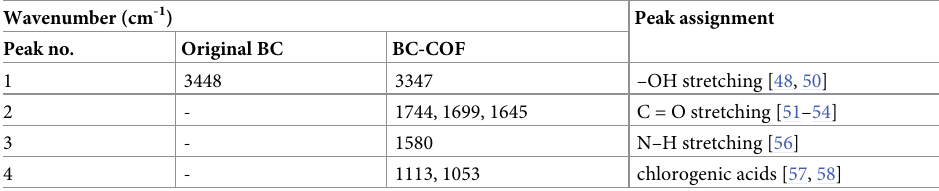
Table 1. Characteristics of peaks of original BC and BC-COF bio-leather (Extraction conditions: Liquor ratio of 1:10 (w/v), coffee at an amount of 200 wt% BC, 90˚C, 1 h; dyeing conditions: Fabric-to-liquor ratio of 1:10 (w/v), 70˚C, 30 min, meta-mordanting with 1% of FeSO 4